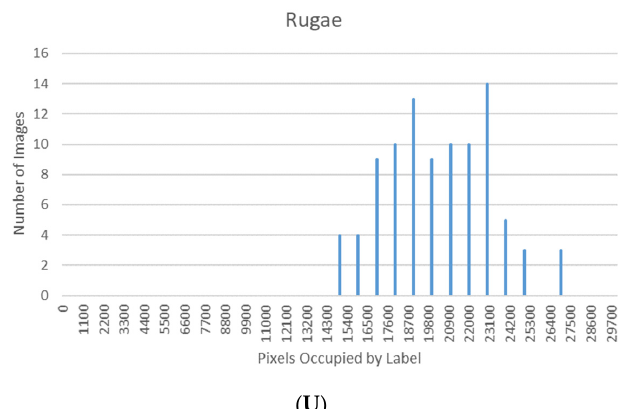
Figure A1. Graphs of the label distribution over the paired set were analyzed. The graphs show the labels’ pixel occupation in an image over the paired image set. The figure ( A – D ) shows the distribution of the the incisor family followed by the canine family ( E , F ), premolars (bicuspid) ( G – J ), molar ( K – P ), primary teeth ( Q – T ), and finally rugae ( U ).